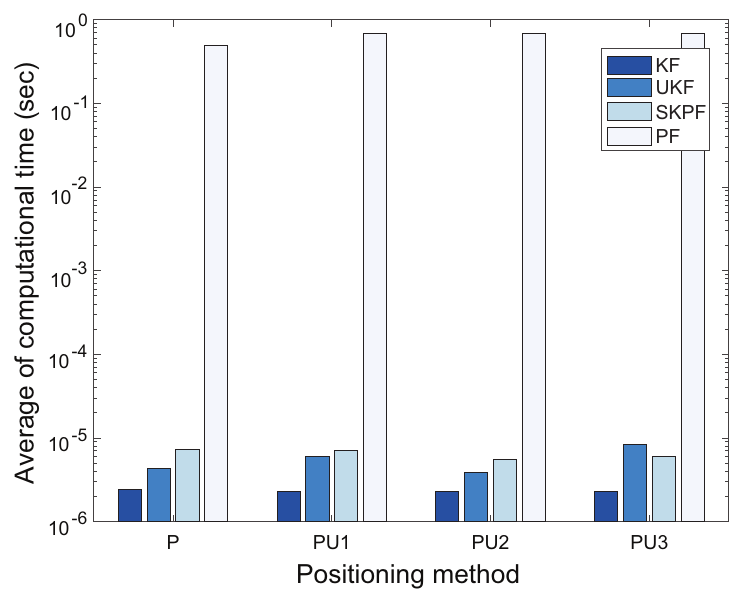
Figure 14. Average of computational time for each positioning method.